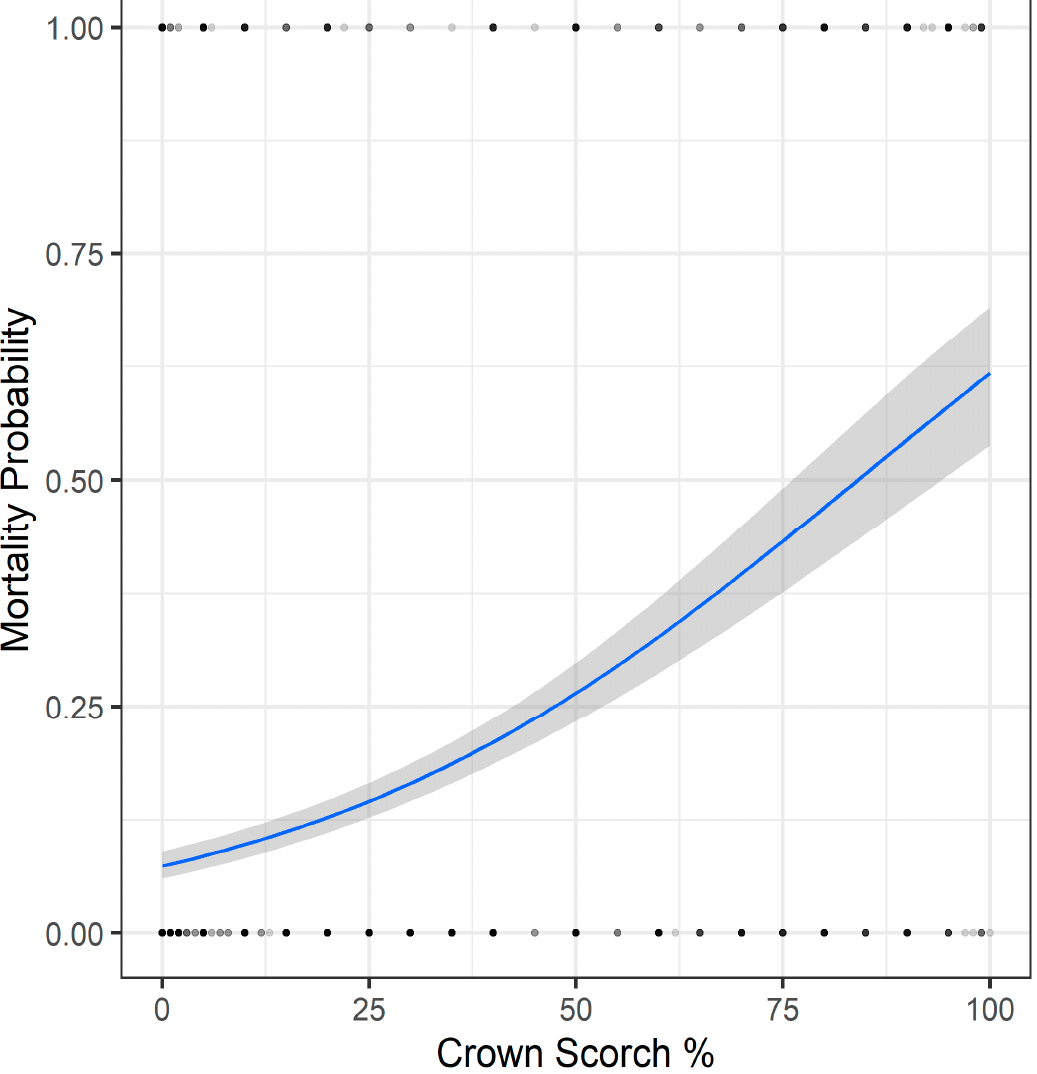
Figure 1. Probability of delayed mortality predicted by logistic model based only on crown scorch (percent), for all six species. Dots on the probability = 1.0 line represent observed delayed mortality trees and dots on the probability = 0, represent survivor trees. Shaded area depicts 95% confidence intervals. Plot generated by ggplot2 [30].